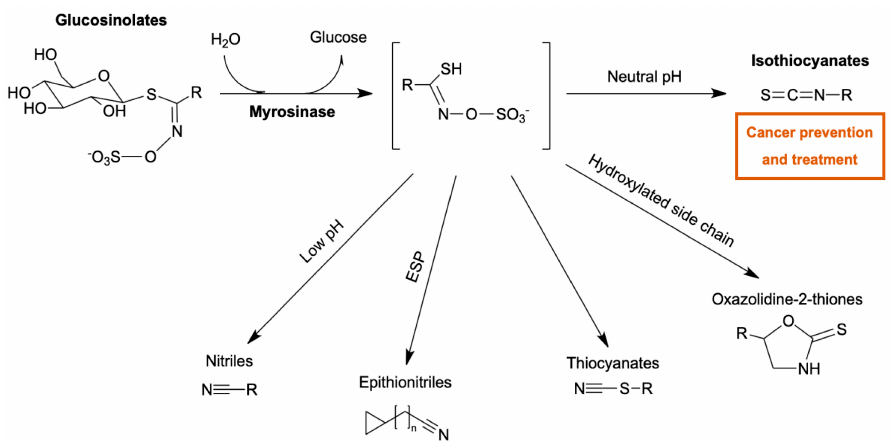
Figure 1. Scheme of glucosinolate hydrolysis. Bioactive products formation after myrosinase-catalysed hydrolysis of glucosinolates, which is affected by pH, the epithiospecifier protein (ESP), and the structure of the amino acid-derived side chain (R).